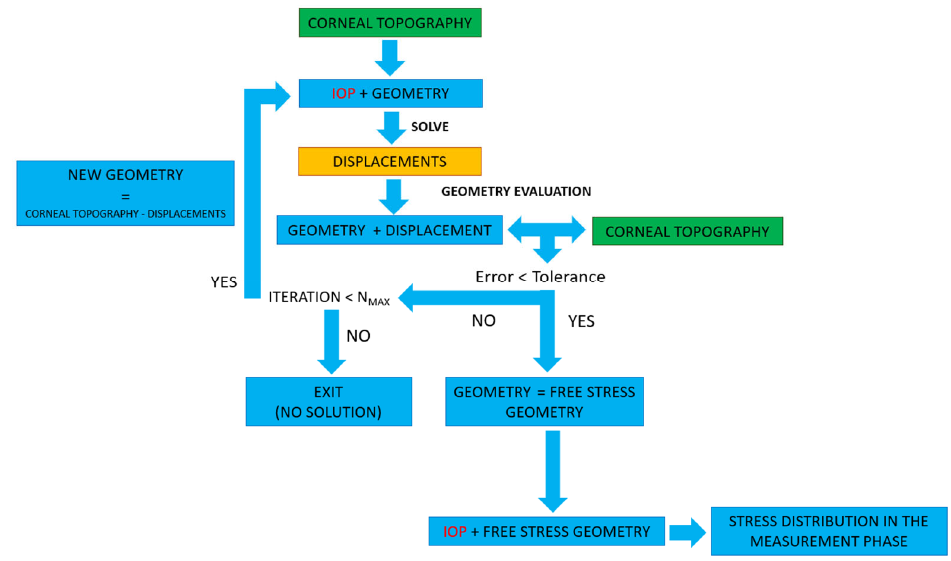
Figure 2. Preliminary stress calculation with displacement method.